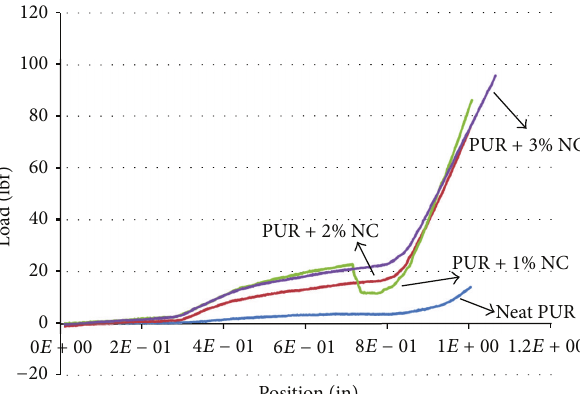
Figure 5: Flexural strength of PUR-nanoclay composites.